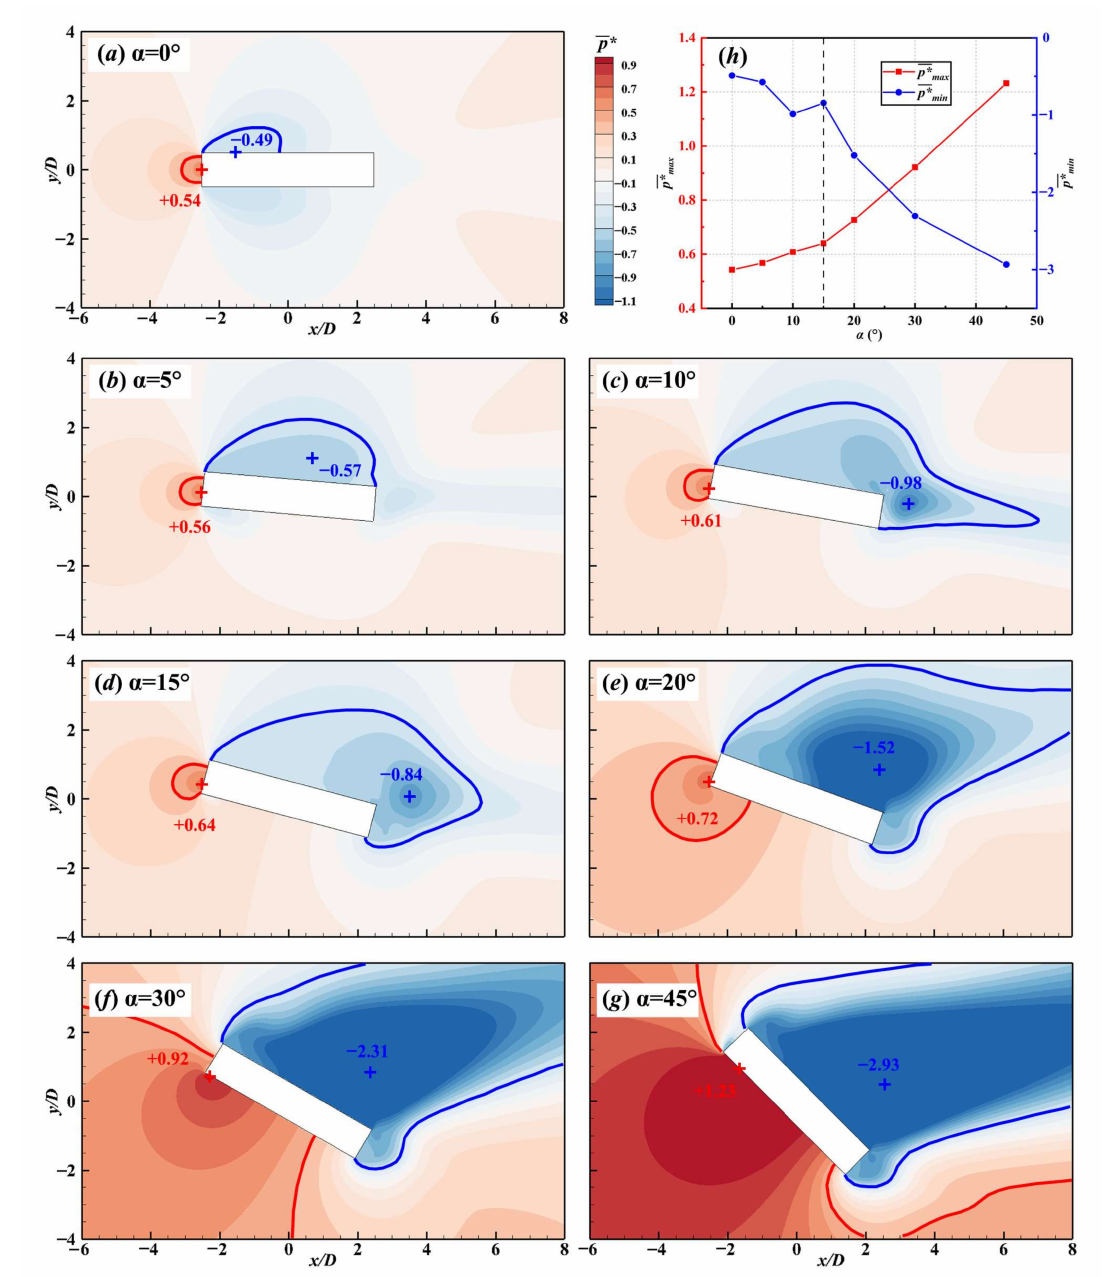
Figure 12. Time-averaged pressure p distribution at different AoA (+ represents the location of the maximum and minimum values, and the blue and red lines represent the contours with p ∗ = − 0.4 and p ∗ = 0.4, respectively). ( a ) α = 0 ◦ , ( b ) α = 5 ◦ , ( c ) α = 10 ◦ , ( d ) α = 15 ◦ , ( e ) α = 20 ◦ , ( f ) α = 30 ◦ , ( g ) α = 45 ◦ , ( h ) The trend of p ∗ with the increase in the